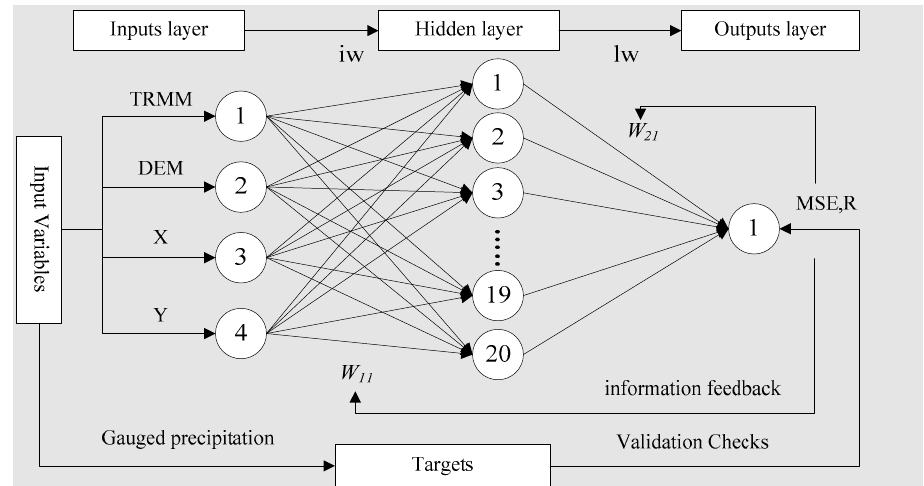
Figure 2. The artificial neural network (ANN) structure diagram.